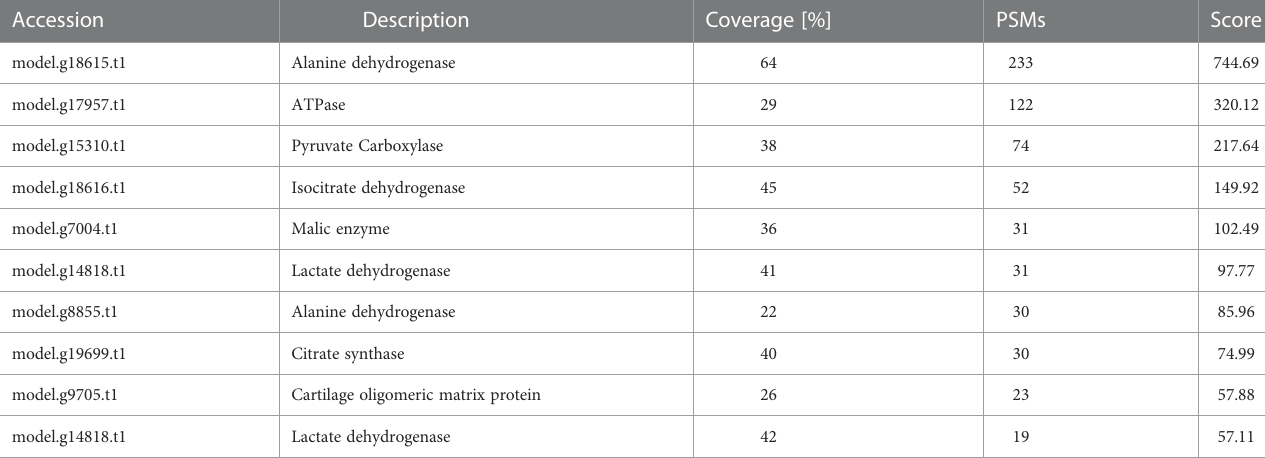
TABLE 2 List of energy-related proteins in the